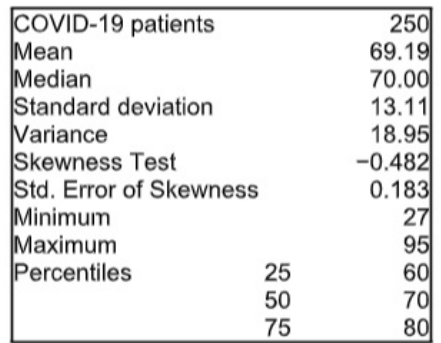
Figure 1. Statistical indicators for age groups.